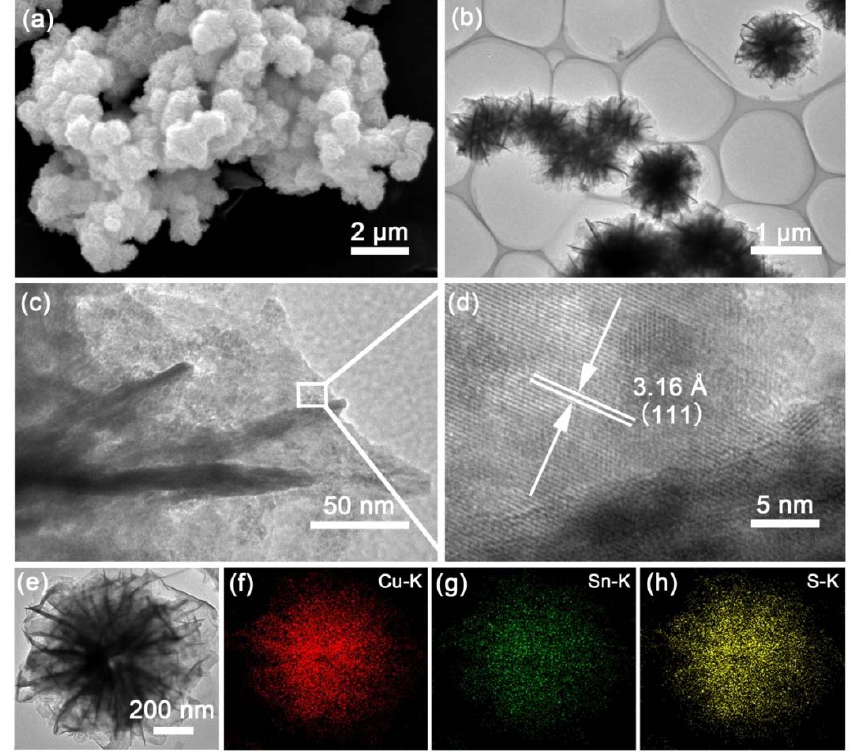
Figure 3. ( a ) SEM, ( b , c ) TEM and ( d ) HRTEM images of CTS. ( e ) TEM image and the corresponding EDX mapping of ( f ) Cu, ( g ) Sn and ( h ) S of the annealed CTS.